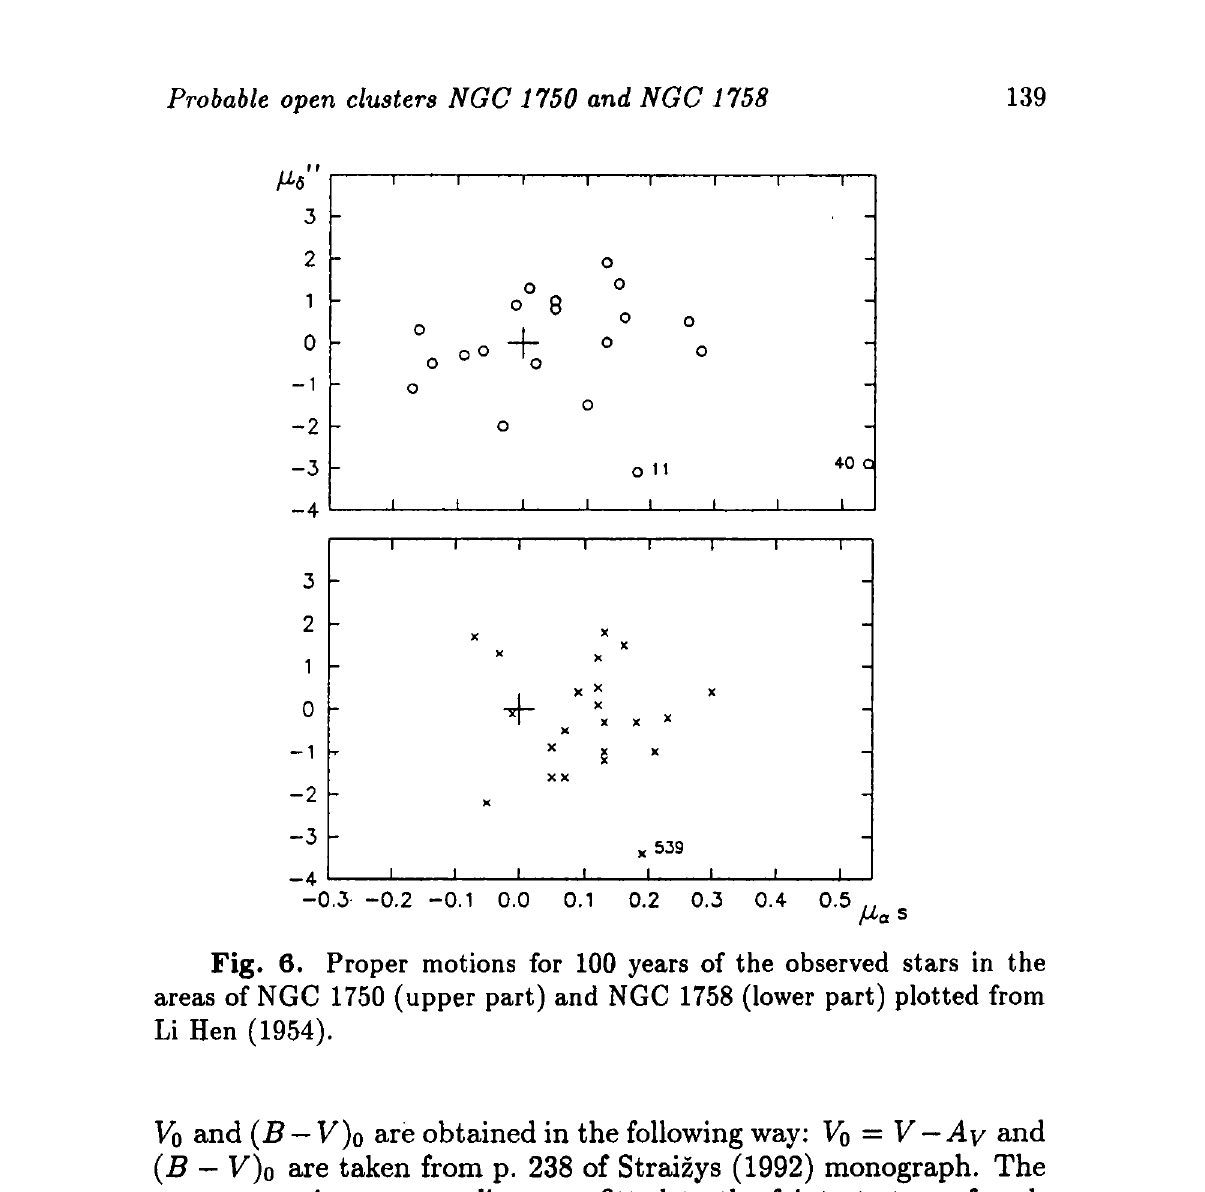
Fig. 6. Proper motions for 100 years of the observed stars in the areas of NGC 1750 (upper part) and NGC 1758 (lower part) plotted from Li Hen